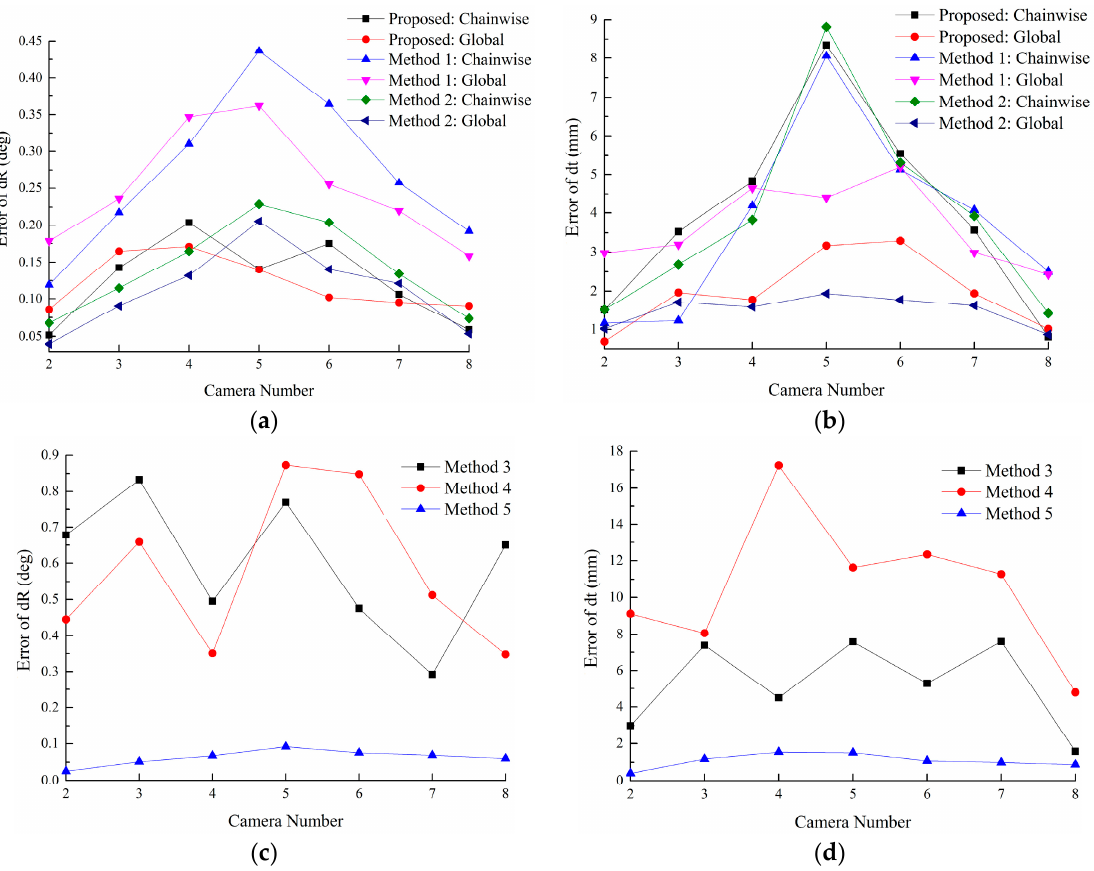
Figure 10. Calibration error of each method: ( a , b ) Errors of rotation vector and translation vector of the proposed method, Methods 1 and 2; ( c , d ) Errors of rotation vector and translation vector of Methods 3, 4 and 5.